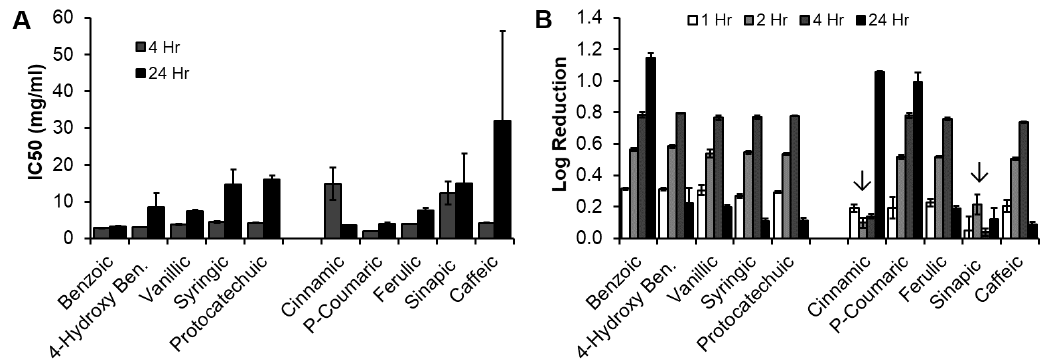
Figure 4. ( A ) IC50 and ( B ) log reduction of PAs against E. coli. n = 3, mean ± standard deviation displayed. Downward arrow indicates low solubility of cinnamic and sinapic acids at 5 mg / mL. Cinnamic acid solubility improved by 24 h, while sinapic acid had low solubility over the full 24-h study.